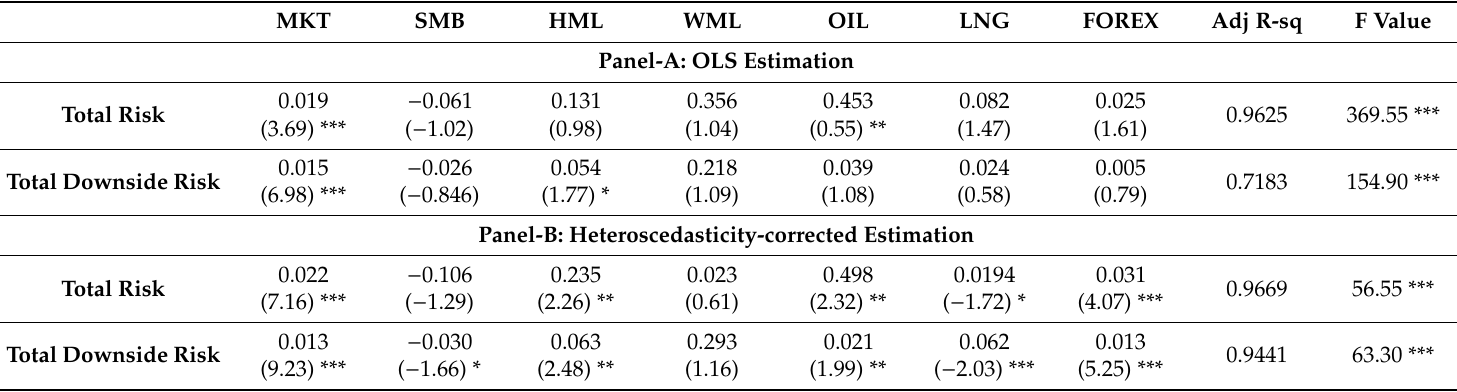
Table 6. Results of Cross-sectional Regression of Downside Risk Exposure on Total